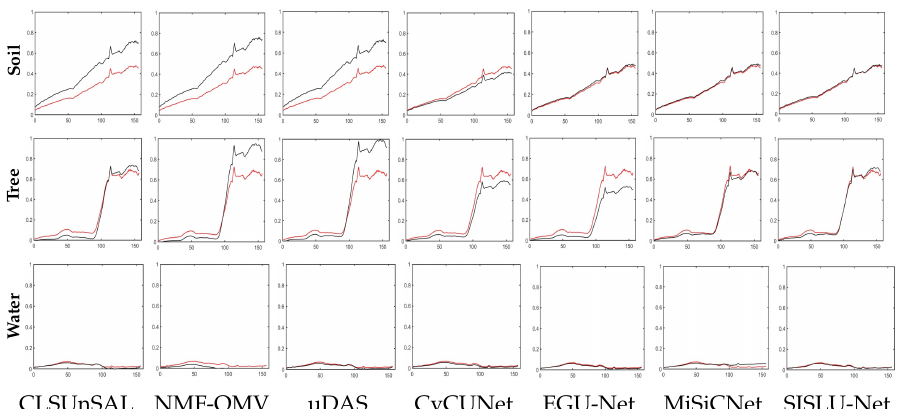
Figure 10. Estimated endmembers by all competing methods on the Samson Dataset. Red: the ground truth endmembers; Black:the estimated endmembers.